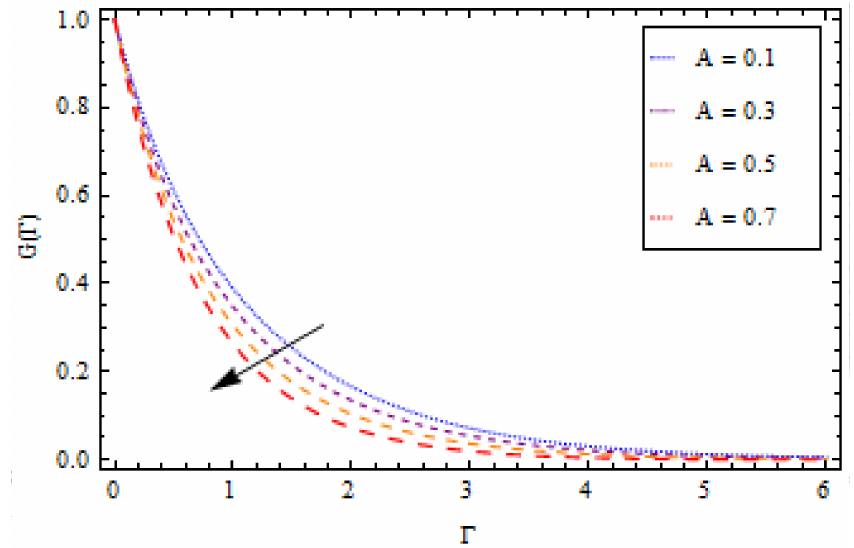
Figure 5. Impact of A on temperature profile G ( Γ ) , when Pr = 0.5, K = 0.5, Rd = 0.5, λ = 0.5, κ = 0.5, γ = 0.5, Sin τ = 1.0.